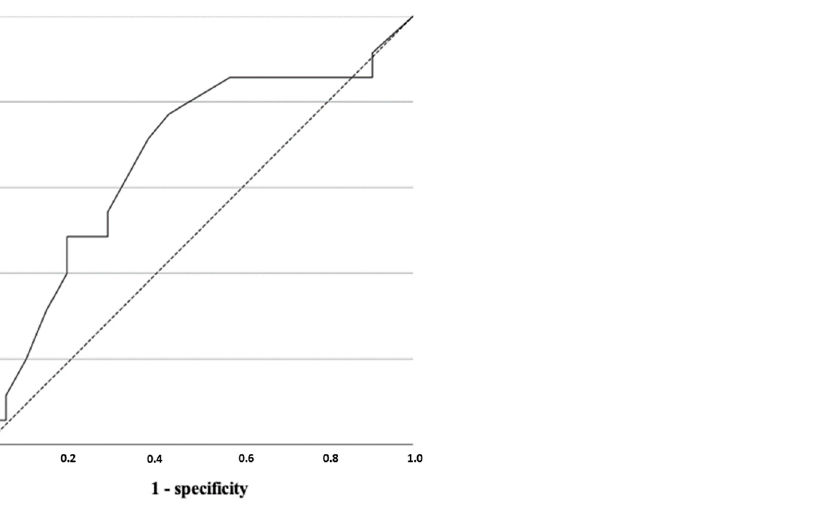
Table 2. Visual score scale of malignant mammary carcinomas according to their histopathological features.